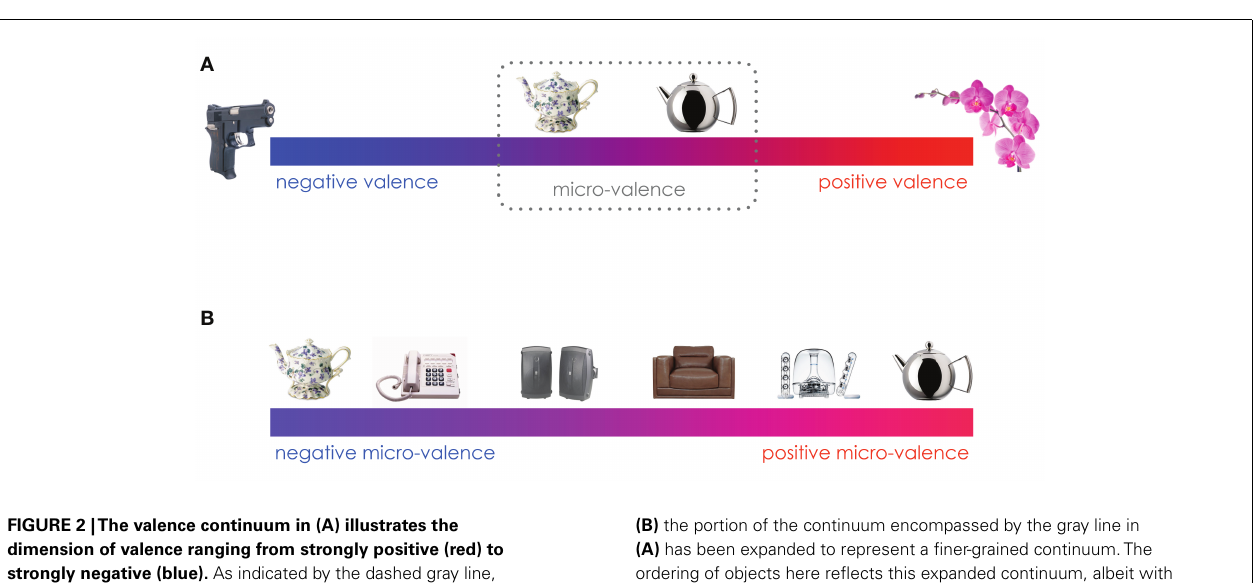
FIGURE 2 |The valence continuum in (A) illustrates the dimension of valence ranging from strongly positive (red) to strongly negative (blue). As indicated by the dashed gray line, objects perceived to have a valence close to the neutral point on the continuum are nonetheless regarded as having a micro-valence. In